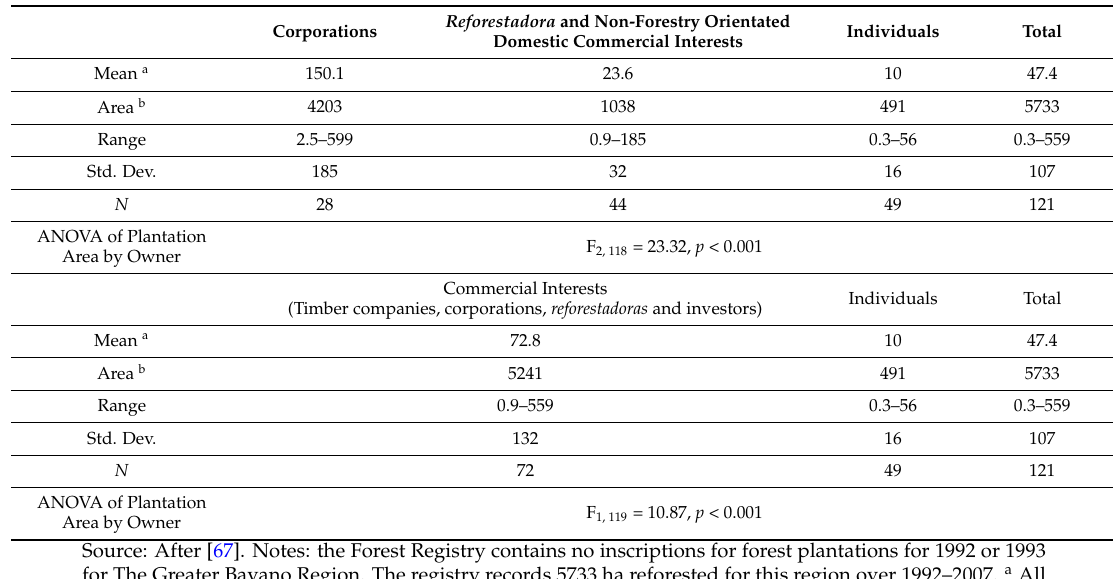
Table 5. Distribution of forest-plantation area between corporate, local commercial and individual plantation owners, Greater Bayano Region, in hectares, 1992–2007.